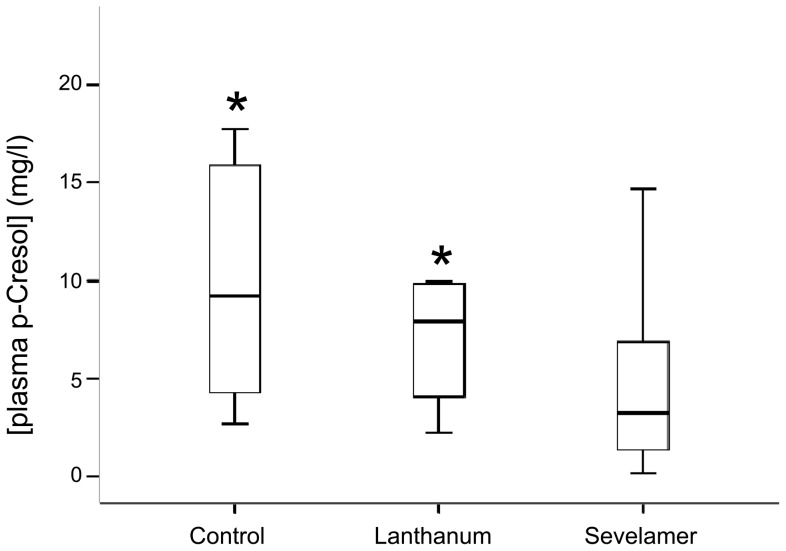
Box and whiskers plot of serum p-cresol levels in patients assuming Sev, lanthanum or no binder.The bars represent median, 25th and 75th percentile of plasma p-cresol. * p<0.05 vs no binder at Dunn's post-hoc test.